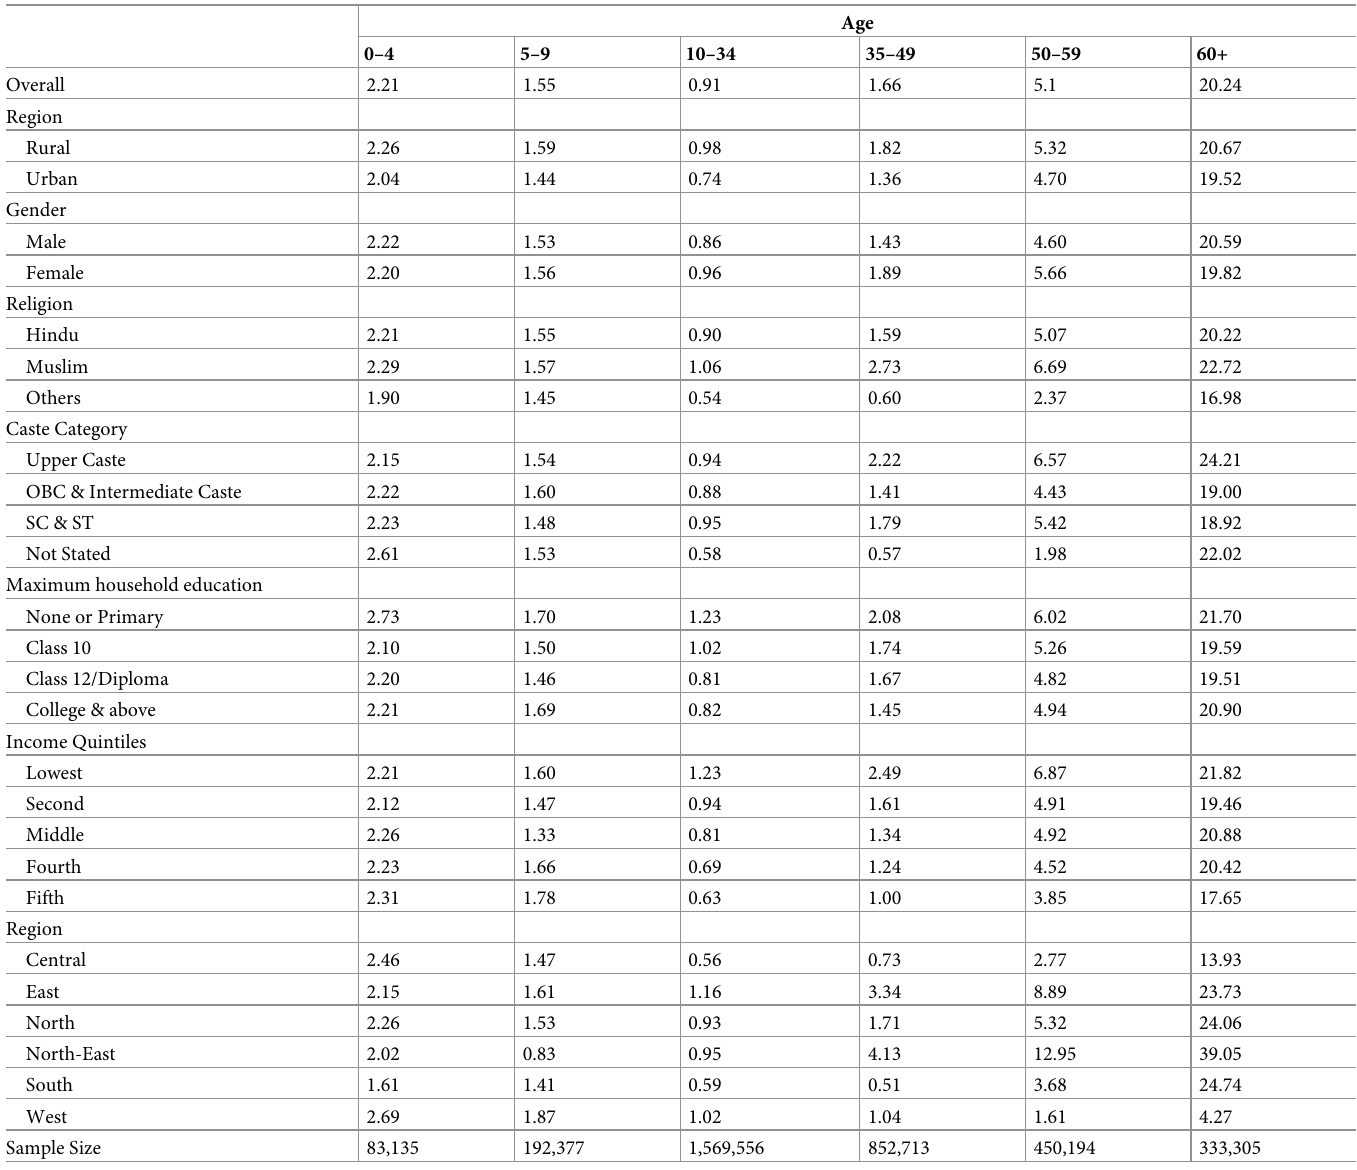
Table 1. Fraction of persons who report